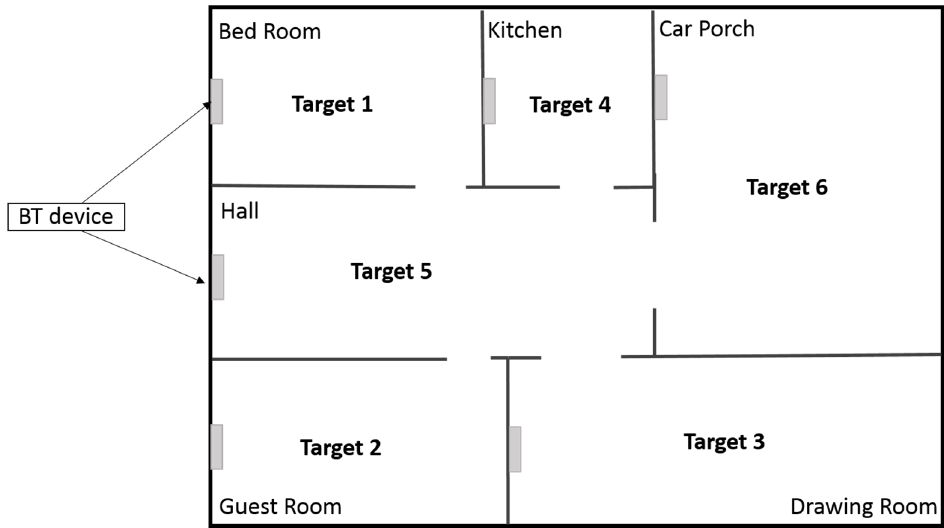
Figure 1. Model of a smart home for a blind person.